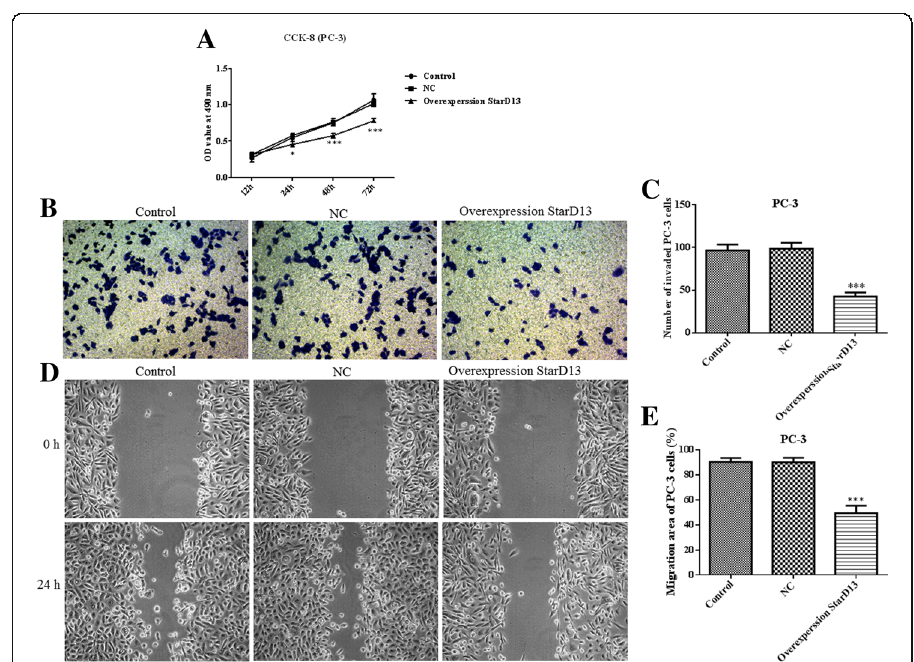
Fig. 8 Cell proliferation, invasion and migration in PC-3 cells transfected with the pcDNA3.1 plasmid of StarD13. a CCK8 assay results. b through c - Transwell invasion assay results. d through e - Wound-healing assay results. ** p < 0.05; *** p < 0.001 vs. NC group. All experiments were performed with at least three